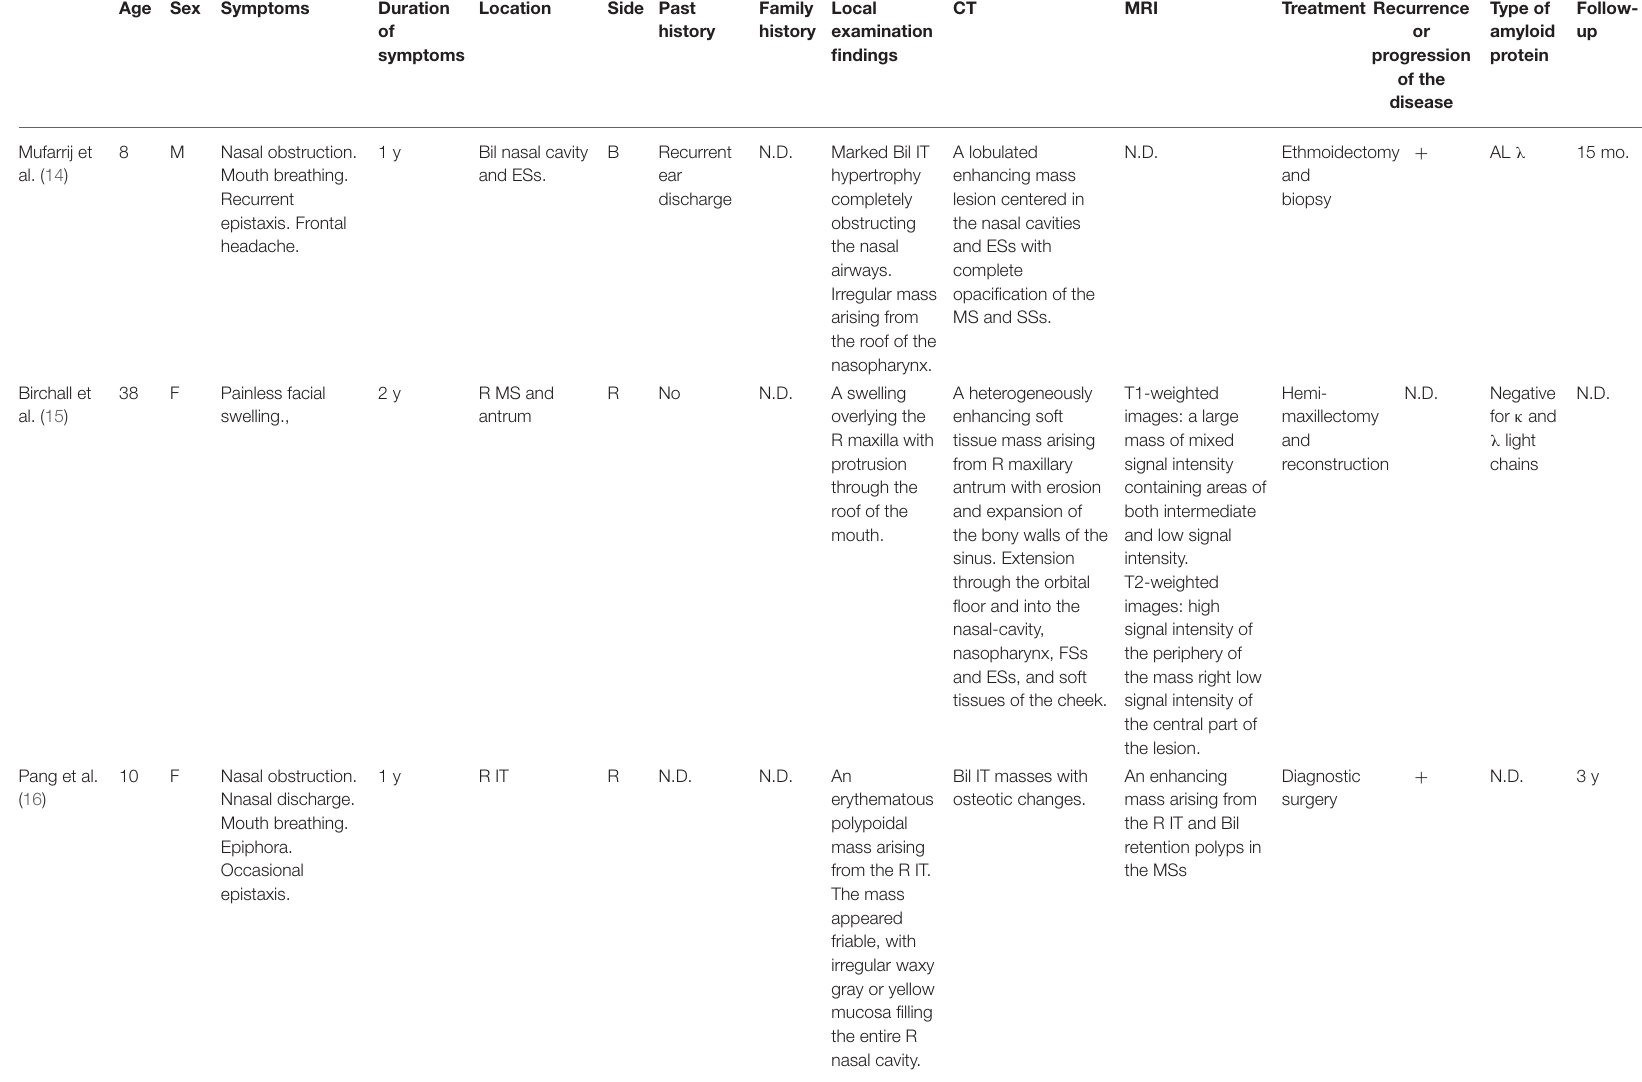
TABLE 1 | Summary of clinical characteristics of previously reported localized sinonasal